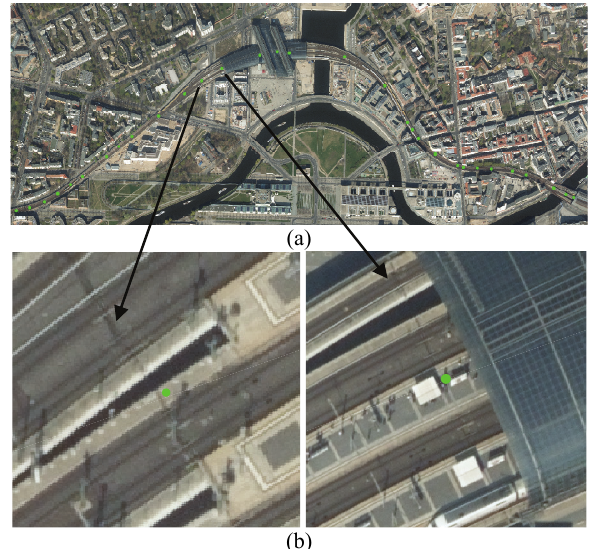
Figure 15. (a) the midpoint of the detected railway joint cross- section marked in green, and (b) close up view of the railway joint. The background optical image has a ground spacing of 20cm.